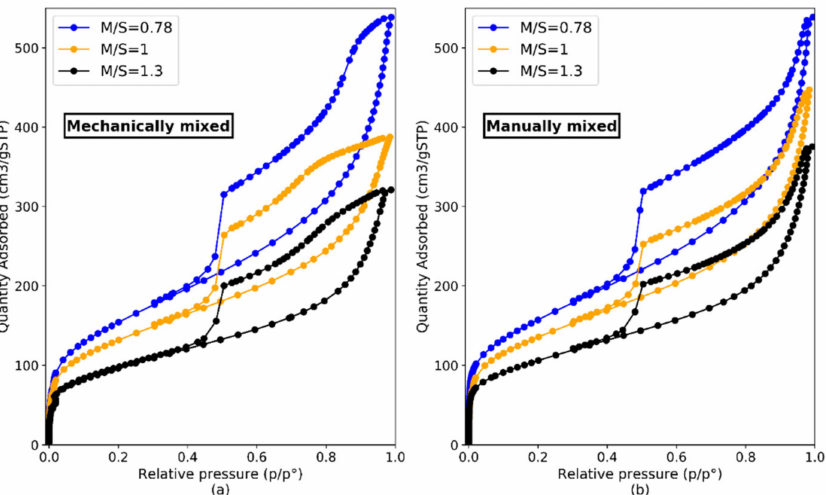
Figure 11. N 2 adsorption-desorption isotherms of M-S-H samples with M/S = 0.78, M/S = 1.0 and M/S = 1.3, mixed mechanically ( a ) or manually ( b ).